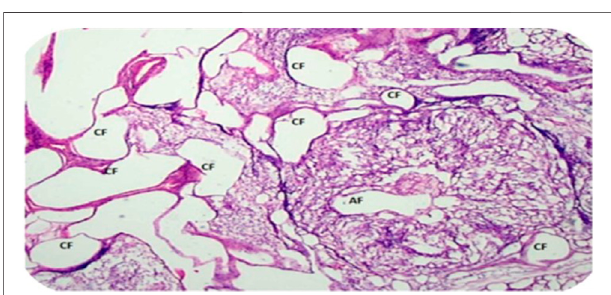
FIGURE 5 | Rotterdam criteria for diagnosis of PCOS and severity of the disorder.